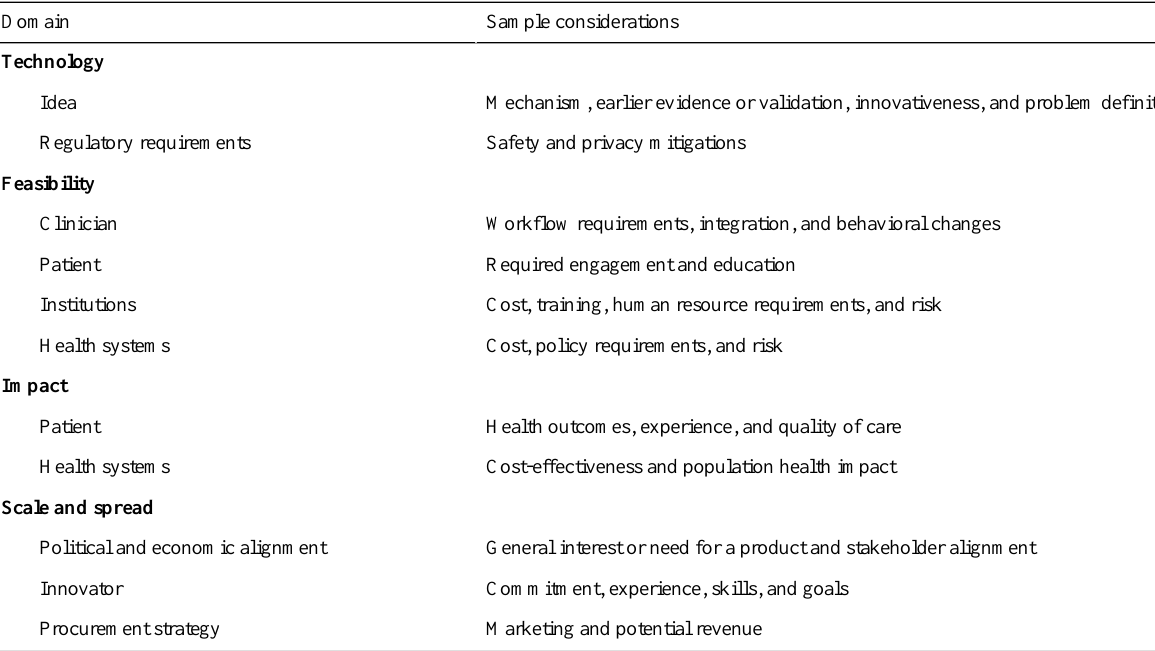
Table 1. Considerations to guide the evaluation of the small- and medium-sized enterprise product, clinical model, and business model. Sample